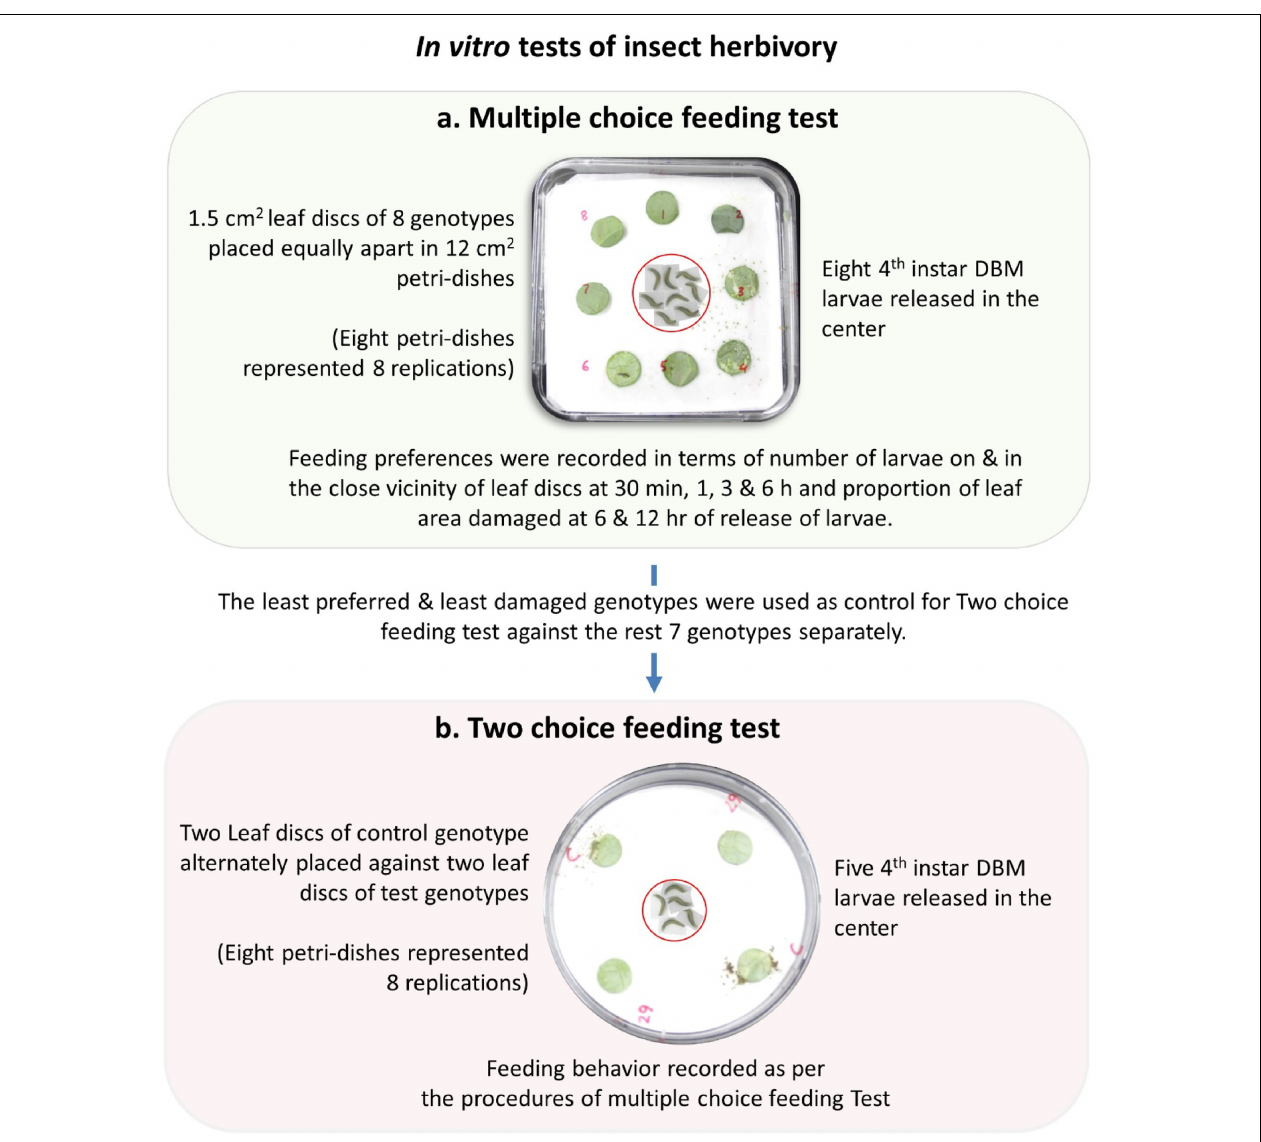
Frontiers in Plant Science |